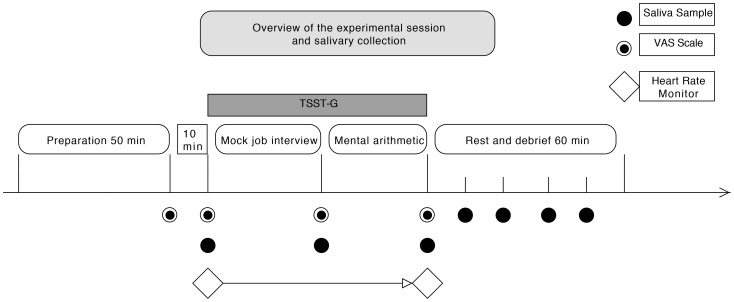
Overview of the exposure session showing collection of saliva samples, VAS scales and heart rate monitoring.